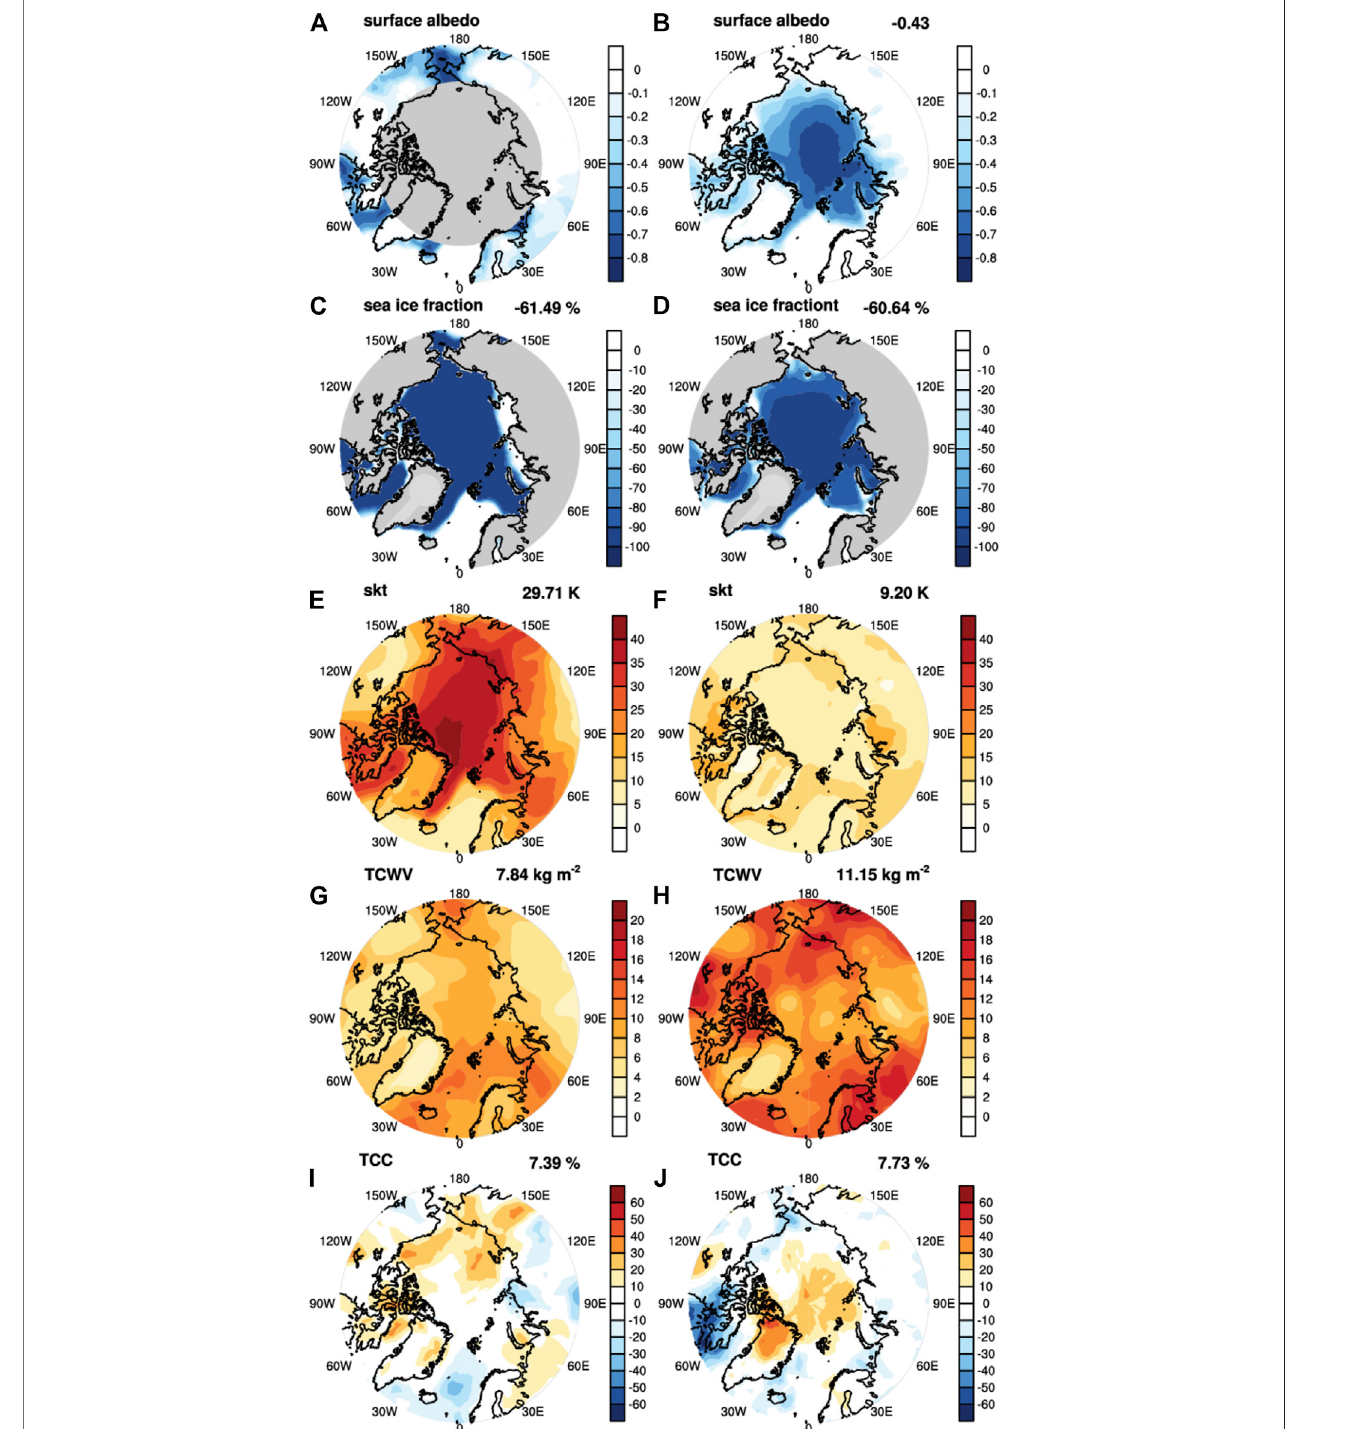
FIGURE 1 | Changes in climate variables in the 4xCO 2 experiment, exempli fi ed by two months a January (left column) and a June (right column) . (A,B) Suface albedo; (C,D) sea ice fraction; (E,F) surface skin temperature; (G,H) column-integrated water vapor; (I,J) total cloud fraction. The numbers on the upper right corner of each panel are the Arctic mean values, averaged over the latitude range of 70 – 90 ° N. Shaded in grey are regions with no data, for instance, due to no solar insolation to infer surface albedo in (A) .